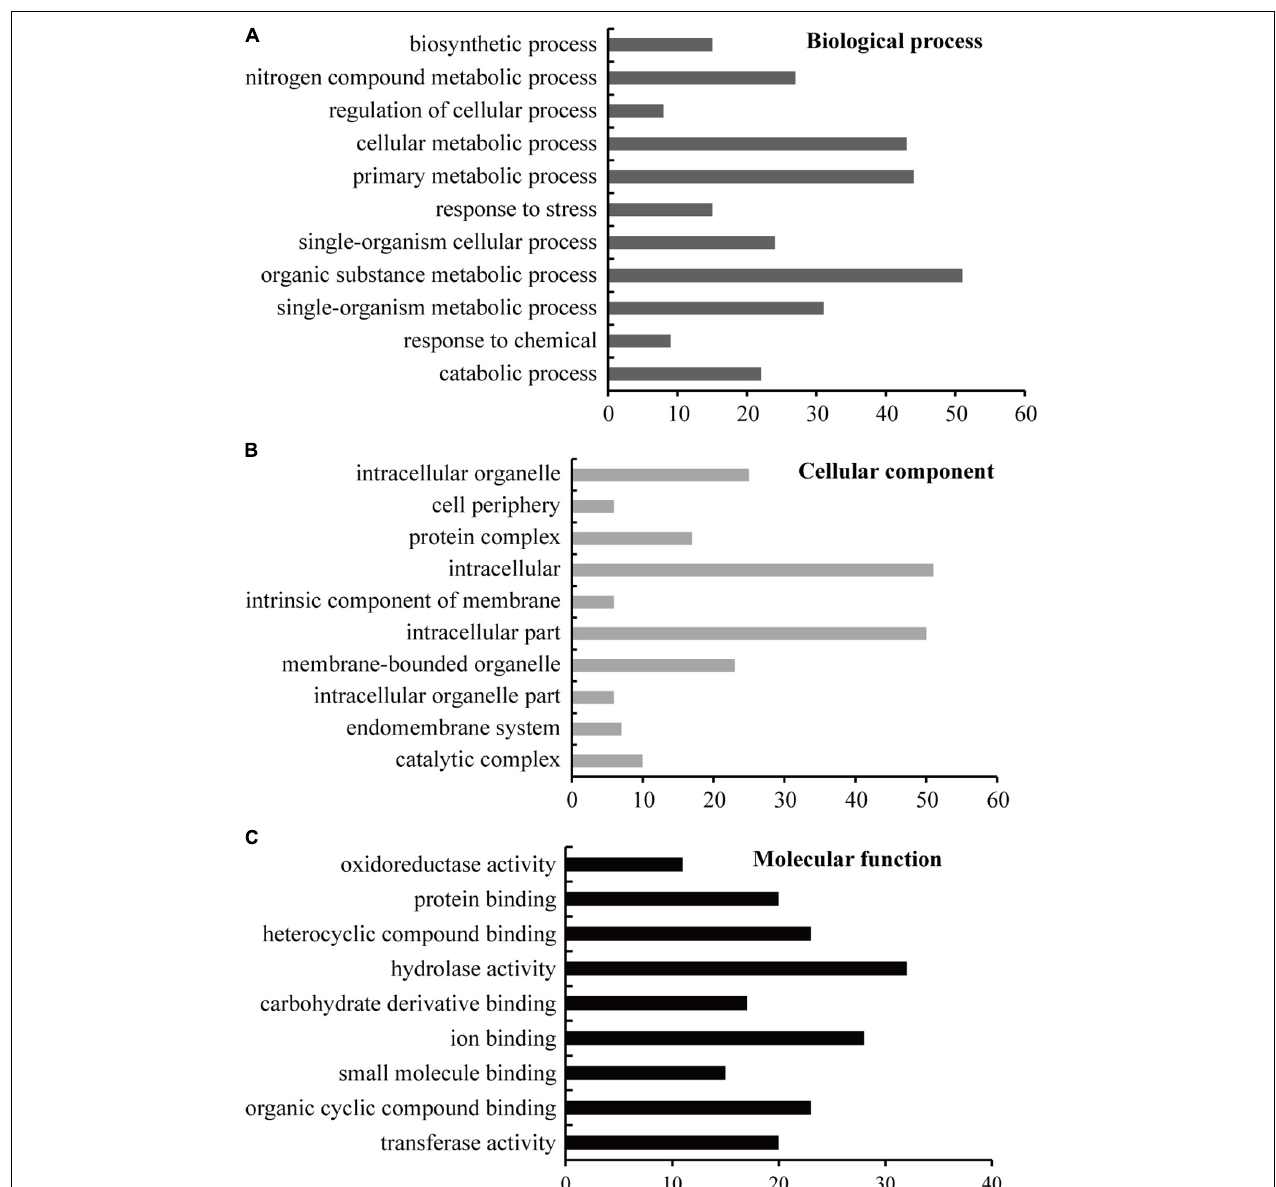
FIGURE 4 | GO enrichment analysis of the identified proteins. The sequence of the identified 114 unique DEPs was lorded into Blast2GO software for blast, mapping, and InterProScan analysis to obtain GO information at the biological process (A) , cellular component (B) , and molecular function (C) levels; level 3 was selected as the final results. The detailed GO information is listed in Supplementary Table S2